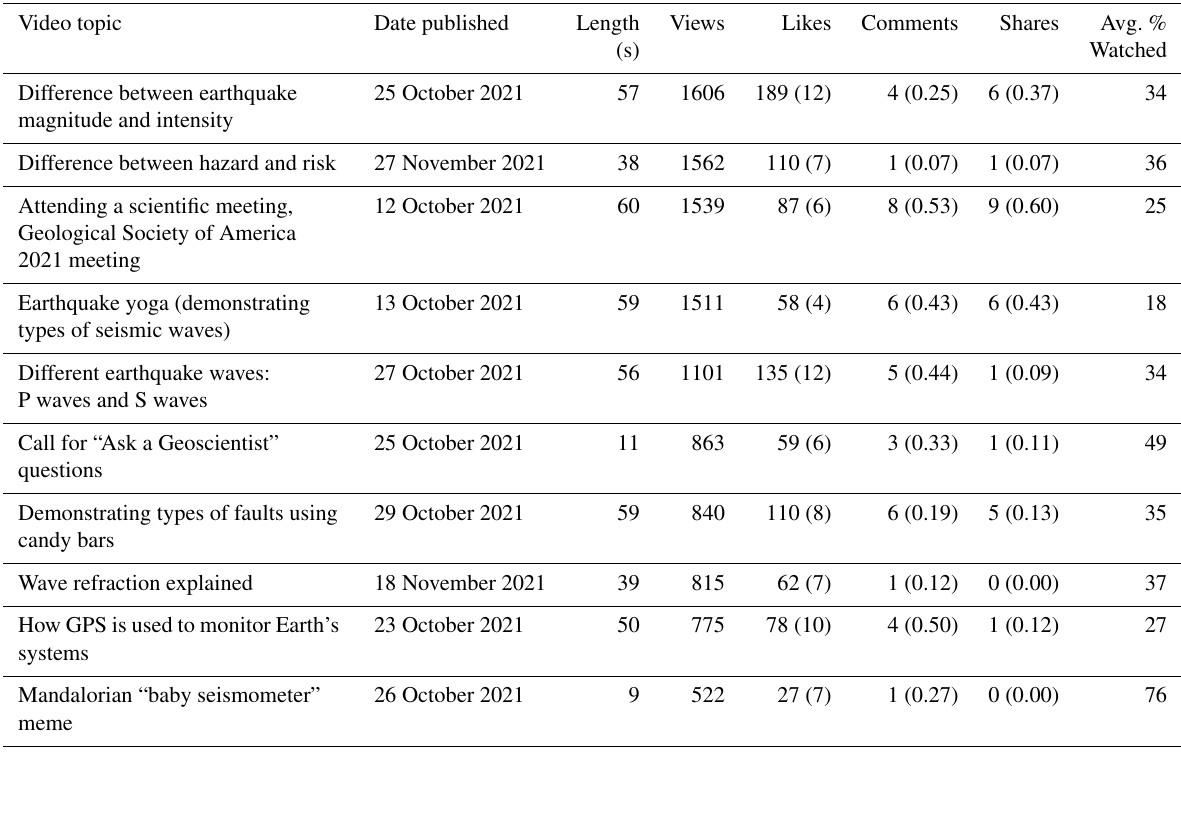
Table 3. The 10 least-viewed videos and corresponding metrics on the Terra Explore account between 8 October 2021 and 6 February 2022. ER: engagement rate (metric / audience reached × 100). These videos correspond to nos. 39–48 in Fig. 4.